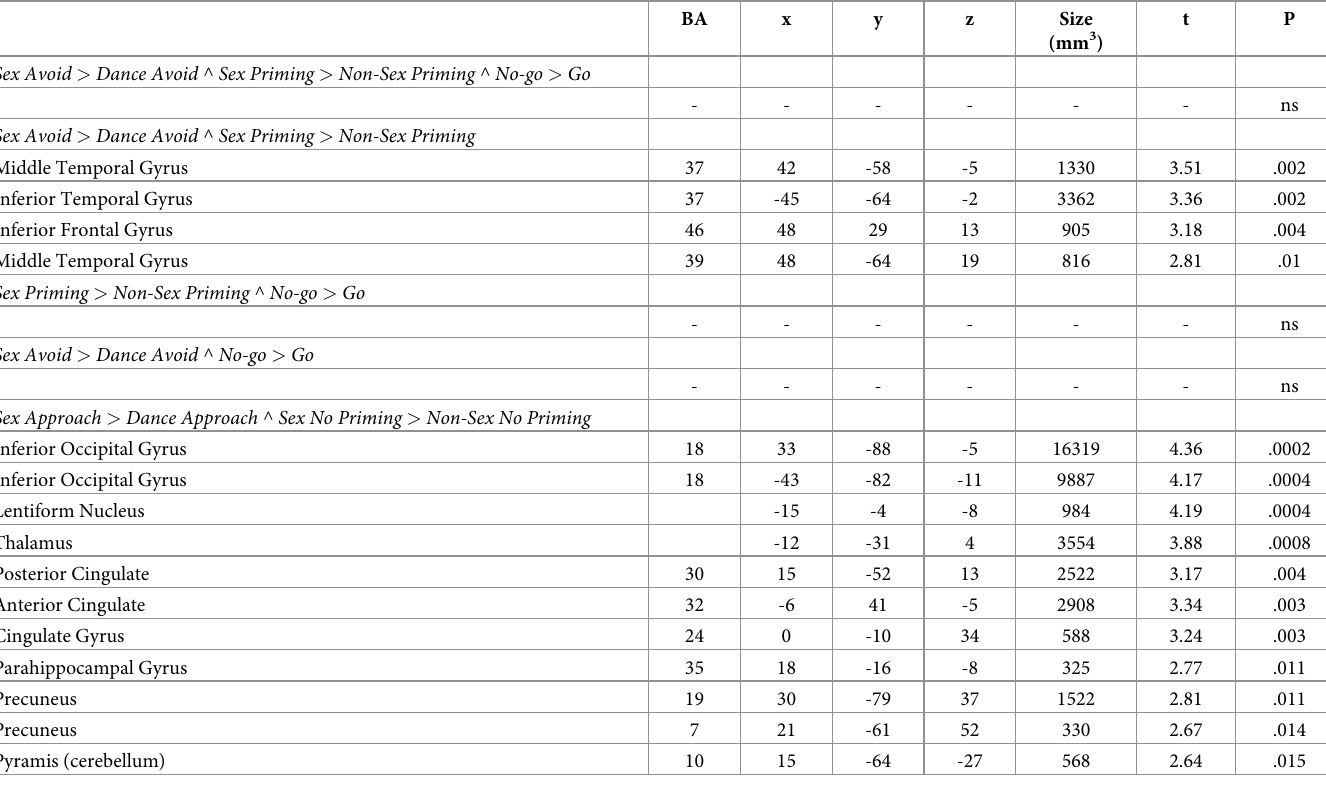
Table 5. Conjunction analyses results for the three inhibitory processes and their paired